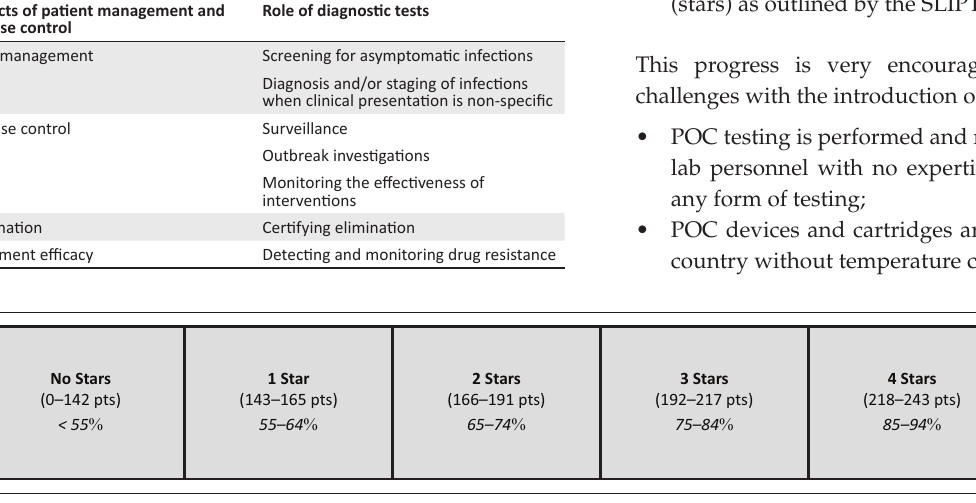
FIGURE 1: Stepwise Laboratory Quality Improvement Process Towards Accreditation (SLIPTA) inspection checklist score corresponds to the number of stars awarded to a laboratory.